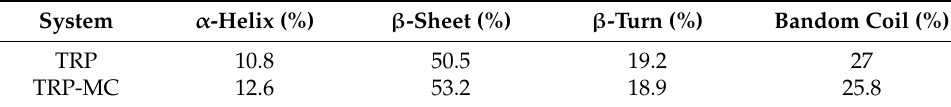
Figure 10. The circular dichroism spectra of MC interacting with TRP. (a): C (TRP) = 1 × 10 − 4 mol/L; (b): C (TRP) = 1 × 10 − 4 mol/L, C (MC) = 1 × 10 − 4 mol/L. Table 5. Secondary Structure Content of MC before and after